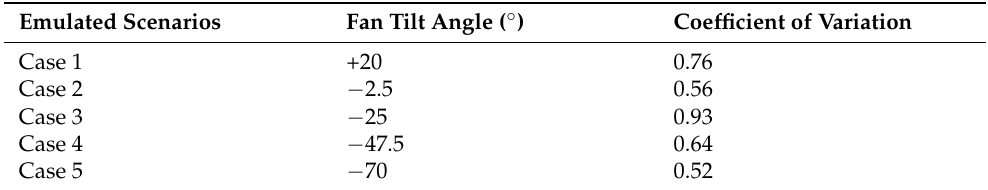
Table 2. Summary of the coefficients of variation of horizontal velocity profiles for different fan tilt angles.